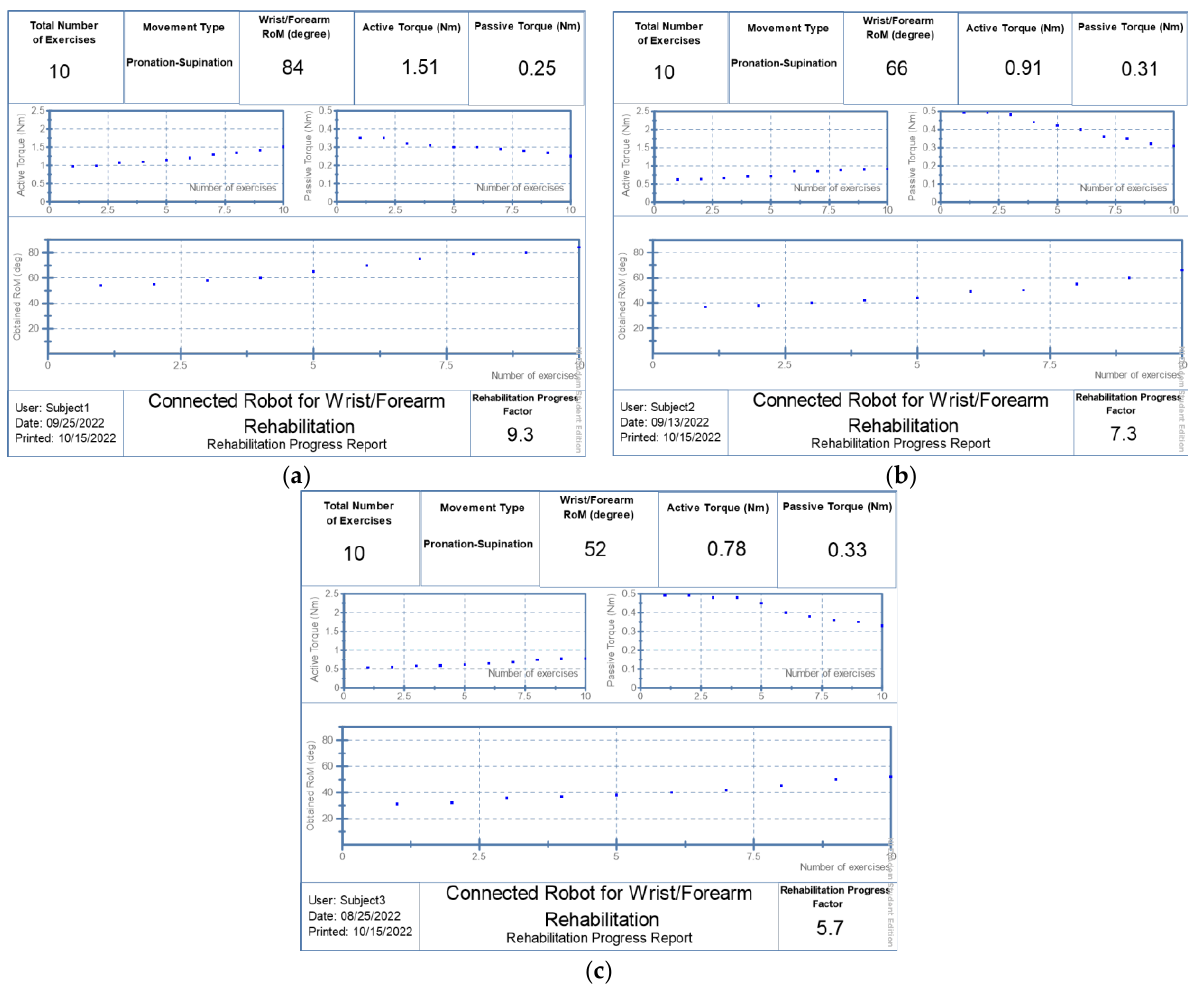
Figure 15. Generated reports: ( a ) patient 1; ( b ) patient 2; ( c ) patient 3.